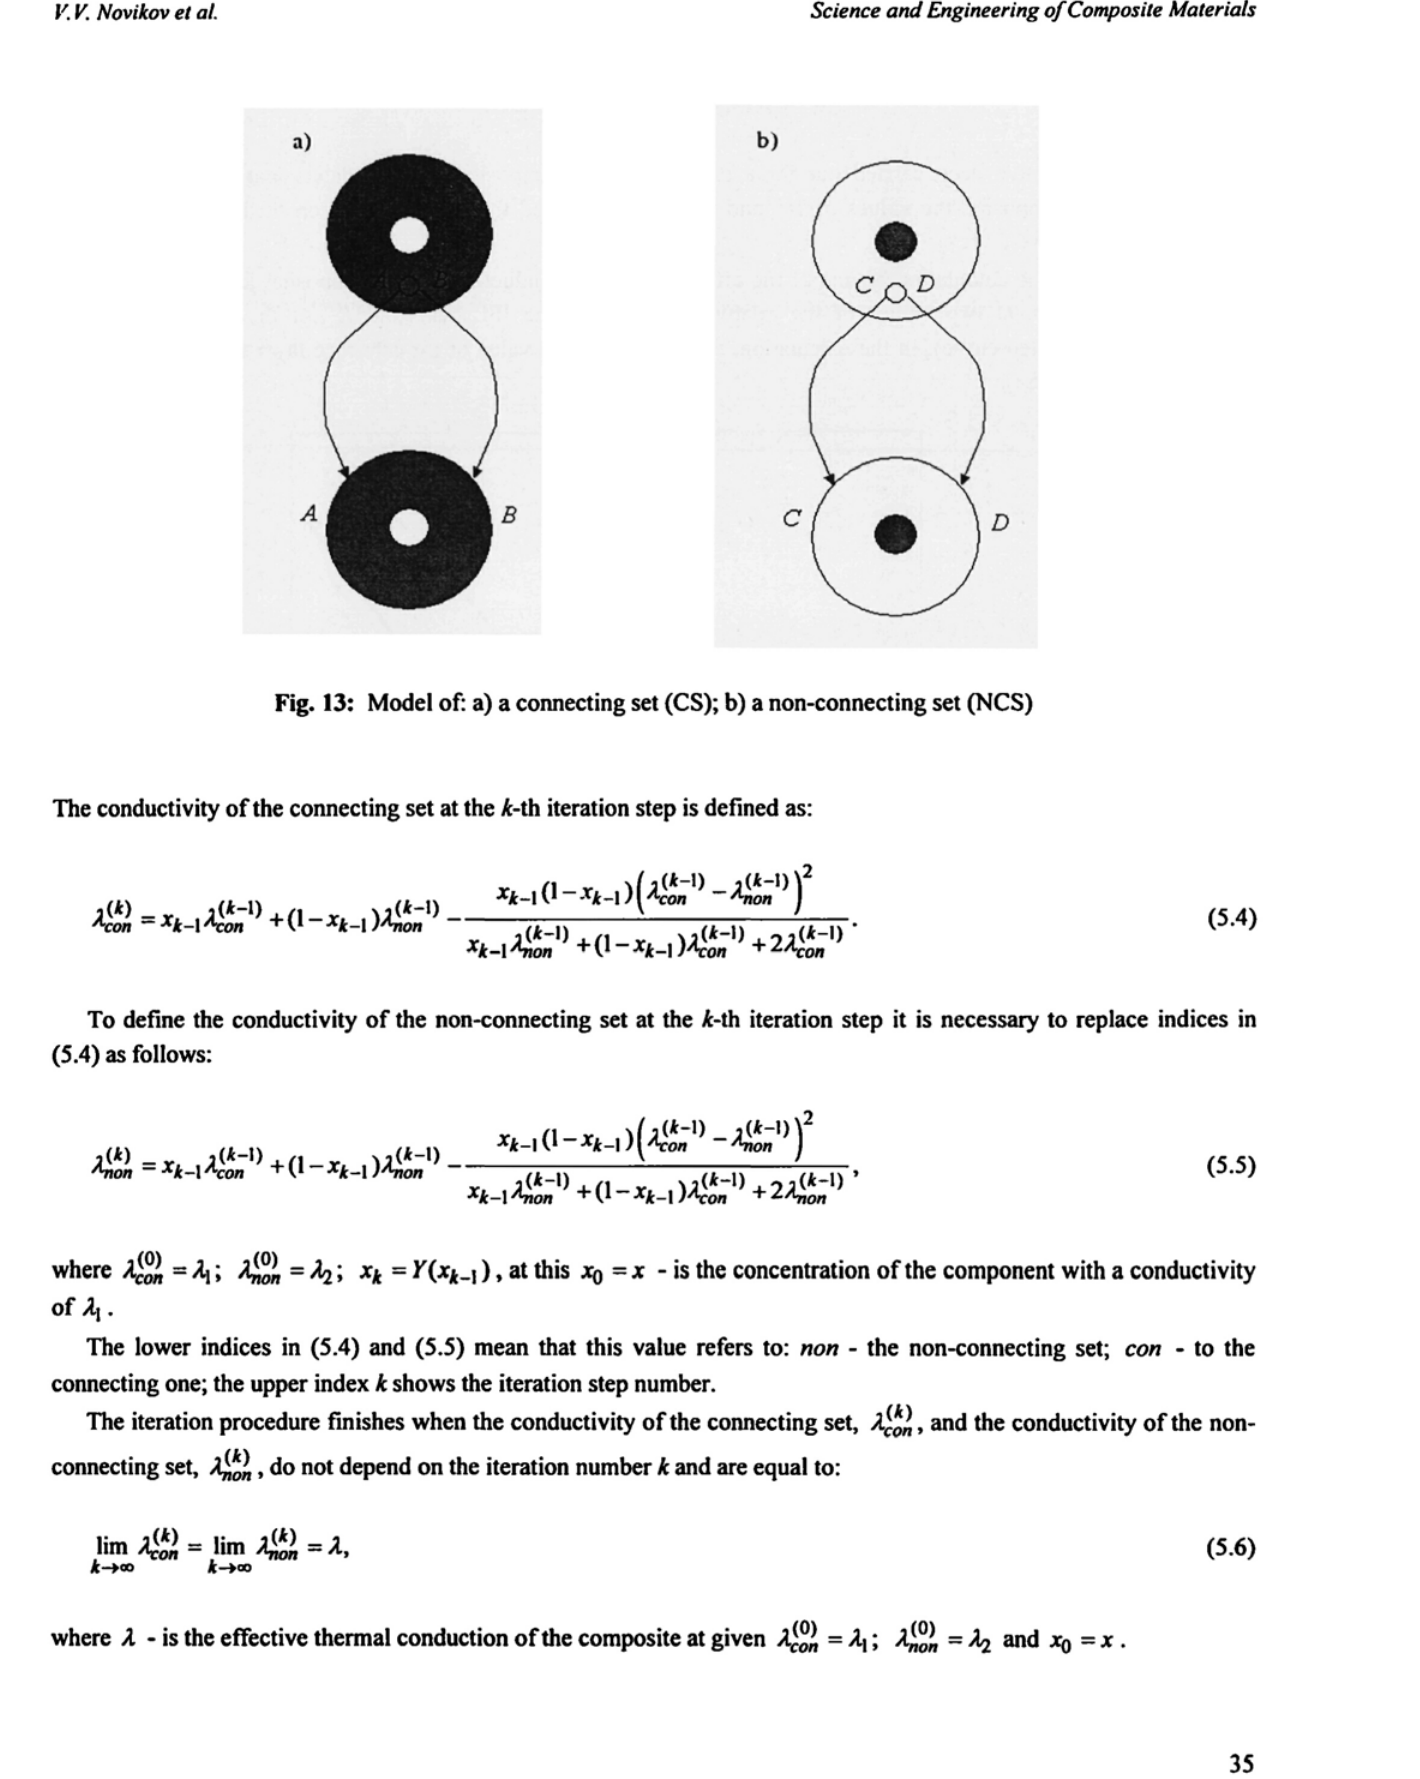
Fig. 13: Model of: a) a connecting set (CS); b) a non-connecting set